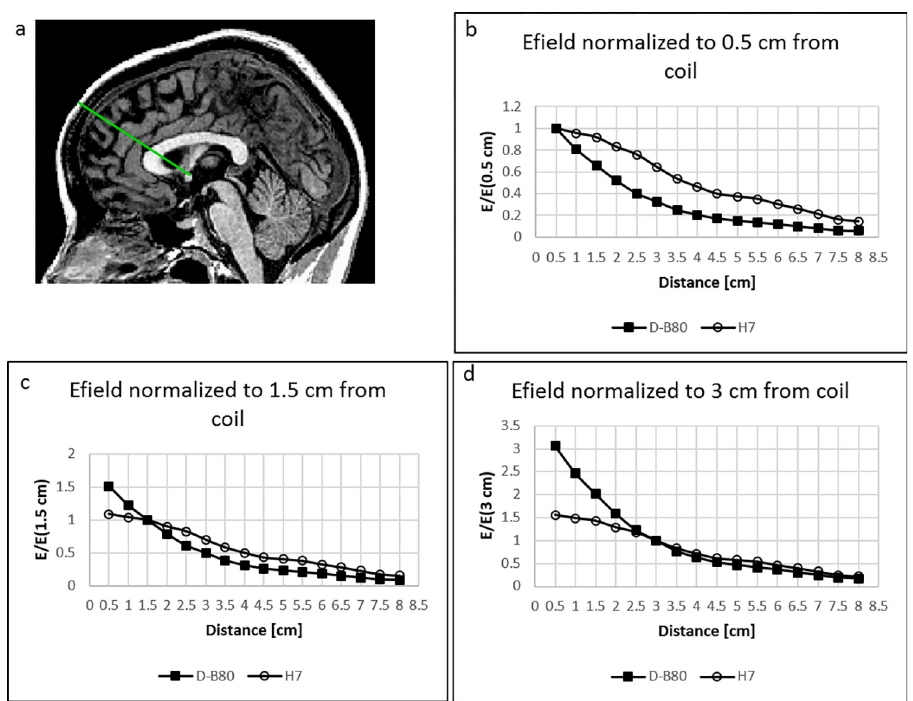
Fig 3. Field decay profile. The electric field magnitude measured in a phantom head model as a function of the distance from the coil, is shown for the D–B80 coil and for the H7 coil, when located at the treatment location over the prefrontal cortex. The field was measured along a line in a central sagittal plane starting at the point of inflection of the frontal bone and going at 45˚ downward and posteriorly (a). The electric field was normalized to the field at the scalp, 0.5 cm from coil surface (b), to the field at the brain surface, 1.5 cm from coil surface (c), and to the field at a depth of 3 cm from coil surface